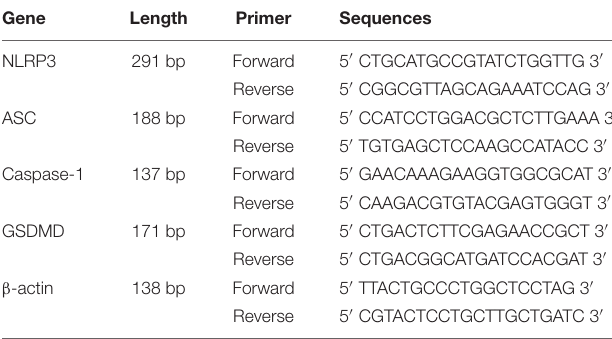
TABLE 1 | The Primer Sequences for